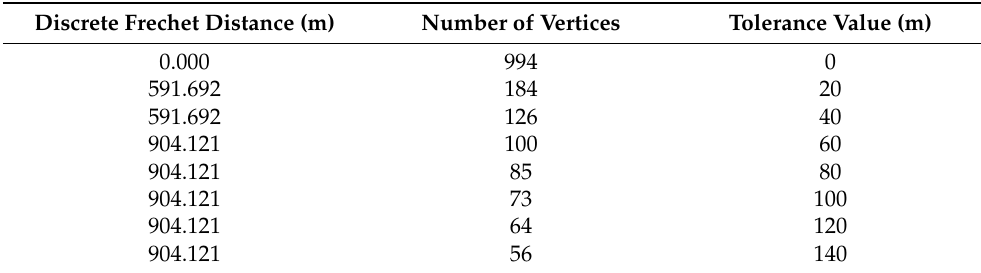
Table 4. Computation of discrete Fr é chet distances per tolerance value (line #1027).